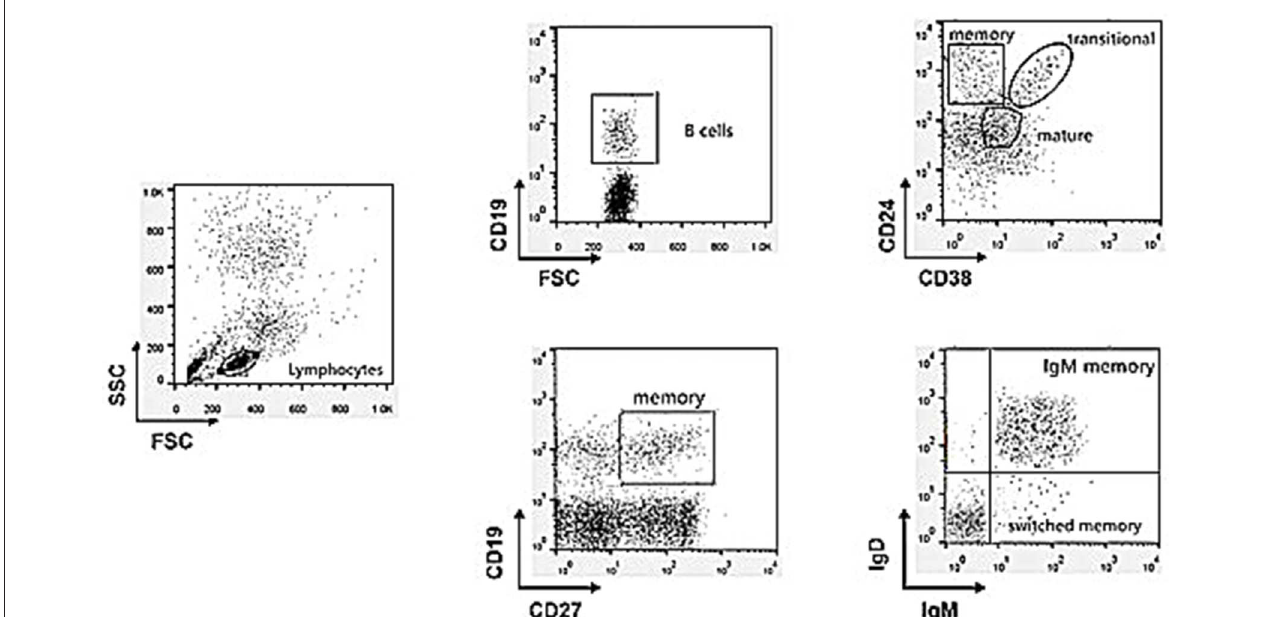
FIGURE 1 | Gating strategy to discriminate the different B cell subpopulations by multicolor flow cytometry